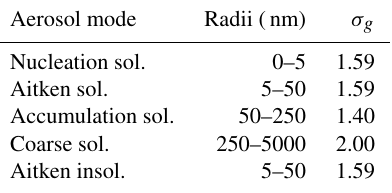
Table 1. The aerosol size distribution in GLOMAP-mode, includ- ing the aerosol modes represented, the range of radii that these in- clude, and their geometric standard deviation.